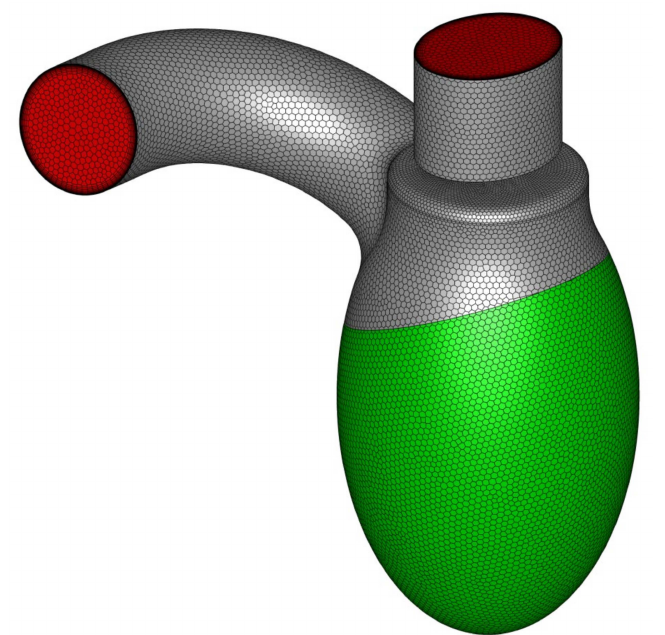
Figure 4. LV geometry with marked boundary condition types: green represents mass flow inlet, whereas red represents pressure